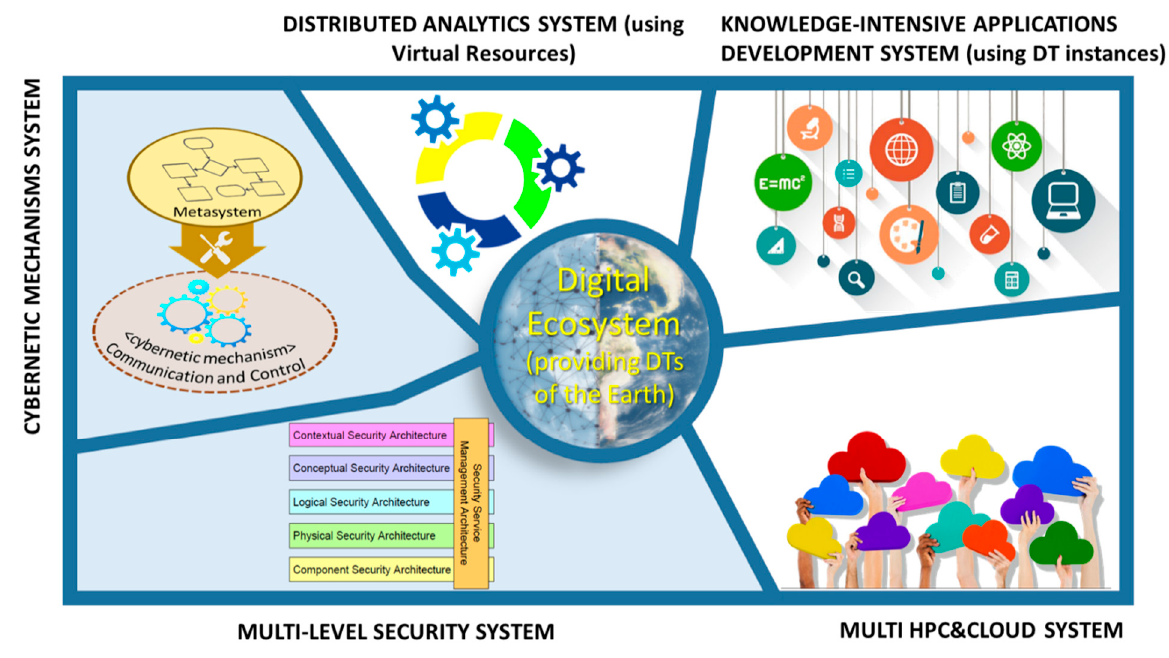
Figure Figure 7. DE functional sub-systems: business related (white background) and secure cybernetic ones (pale blue back- ground) .